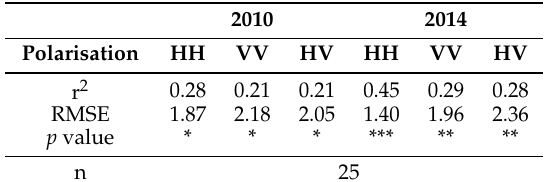
Table 5. Statistical relationships between S-band backscattering ( σ °) to average canopy height.